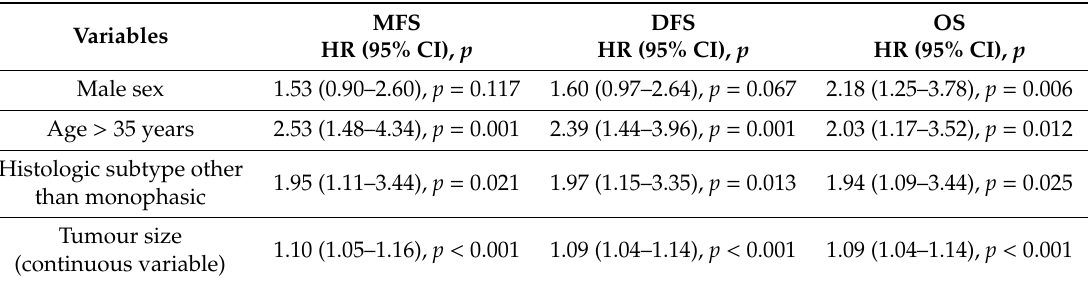
Table 3. Multivariate analysis of variable factors for MFS, DFS and